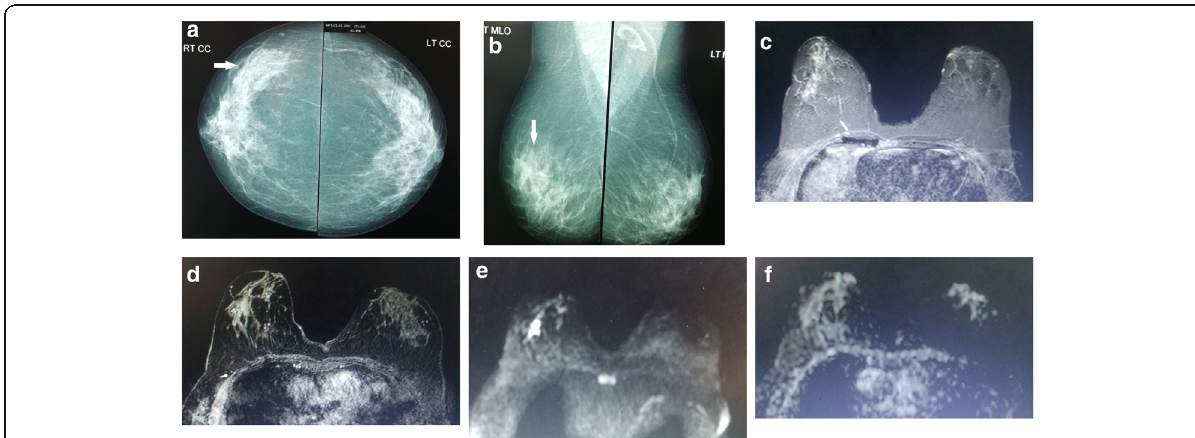
Fig. 6 A 68-year-old female patient with right mastalgia. Mammography craniocaudal ( a ) and mediolateral oblique ( b ) views show focal asymmetry in the right upper quadrant. This is associated with suspicious amorphous microcalcifications (BIRADS IV lesion). Axial STIR ( c ) image shows an ill-defined hyperintense segmental area seen in the right upper outer quadrant with dilated ducts. Axial TI contrast-enhanced fat- suppressed image on dynamic sequence ( d ) shows heterogeneous segmental non-mass enhancement with linear ductal extension towards the nipple. Dynamic time-intensity curve shows type II plateau curve (not shown). The lesion shows hyperintense signal in DWI at b value = 400 ( e ) denoting restricted diffusion, and low signal on ADC map ( f ) with measured ADC value 1.22 × 10 – 3 mm 2 /s. MRI findings: BIRADS IV